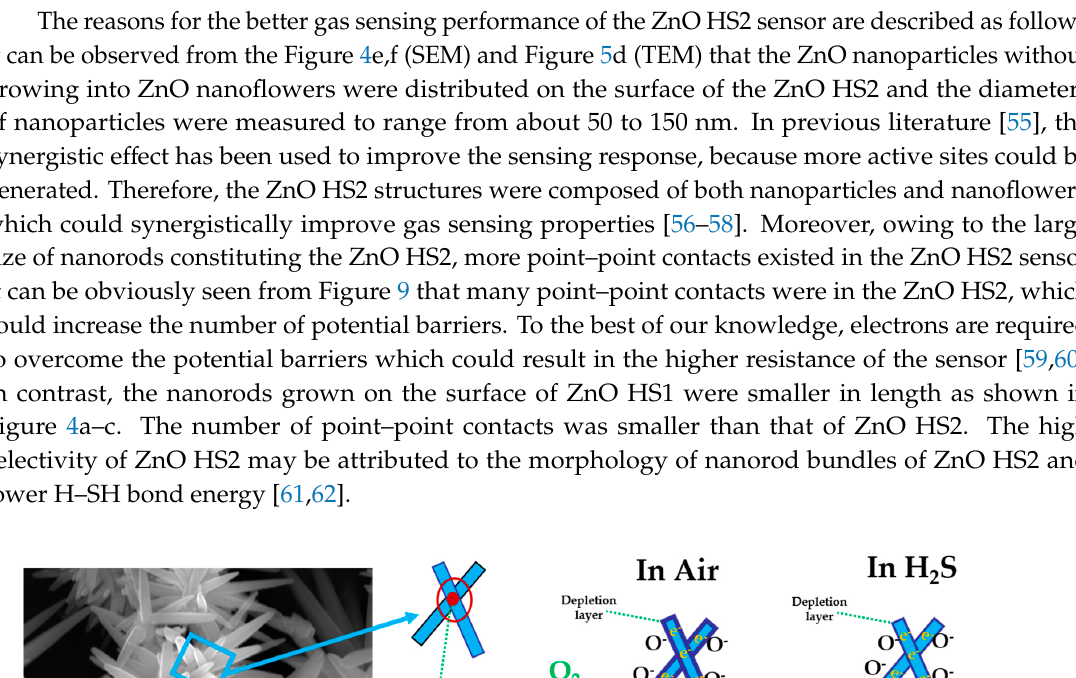
Figure S1: SEM image of the ultra-sounded ZnO NFs; Figure S2: SEM images of as-prepared ( a ) ZnO HS1 sample and ( b ) ZnO HS2 samples after application in the gas